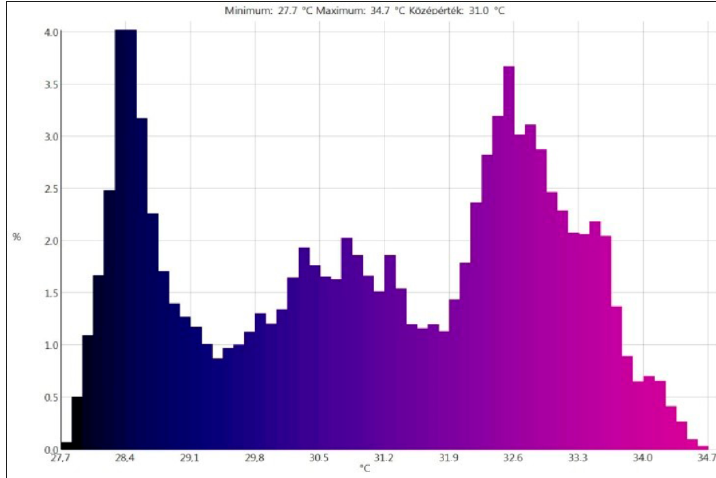
Figure 6. Histogram of the surface temperatures (external window—February 2020).